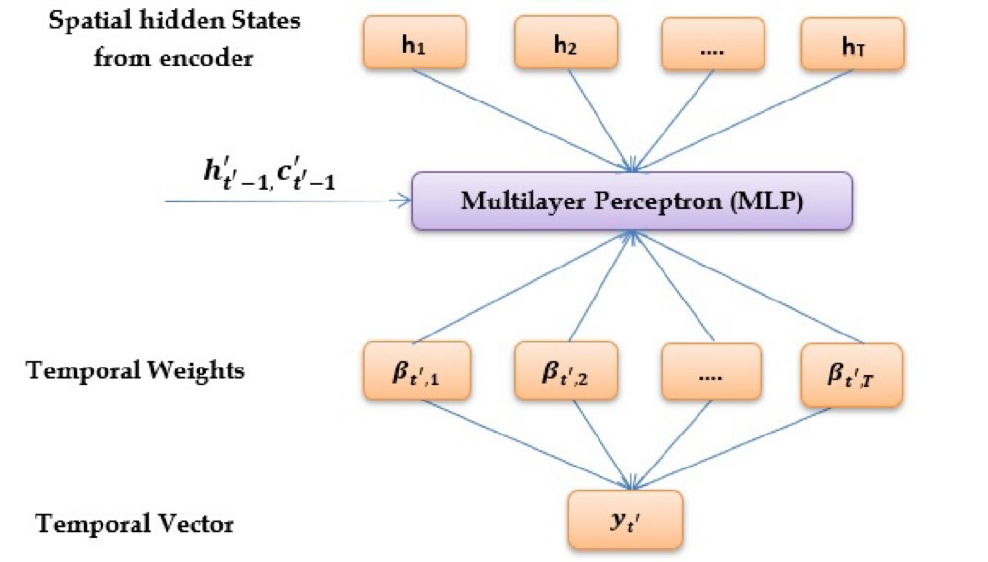
Figure 4. Temporal attention model in